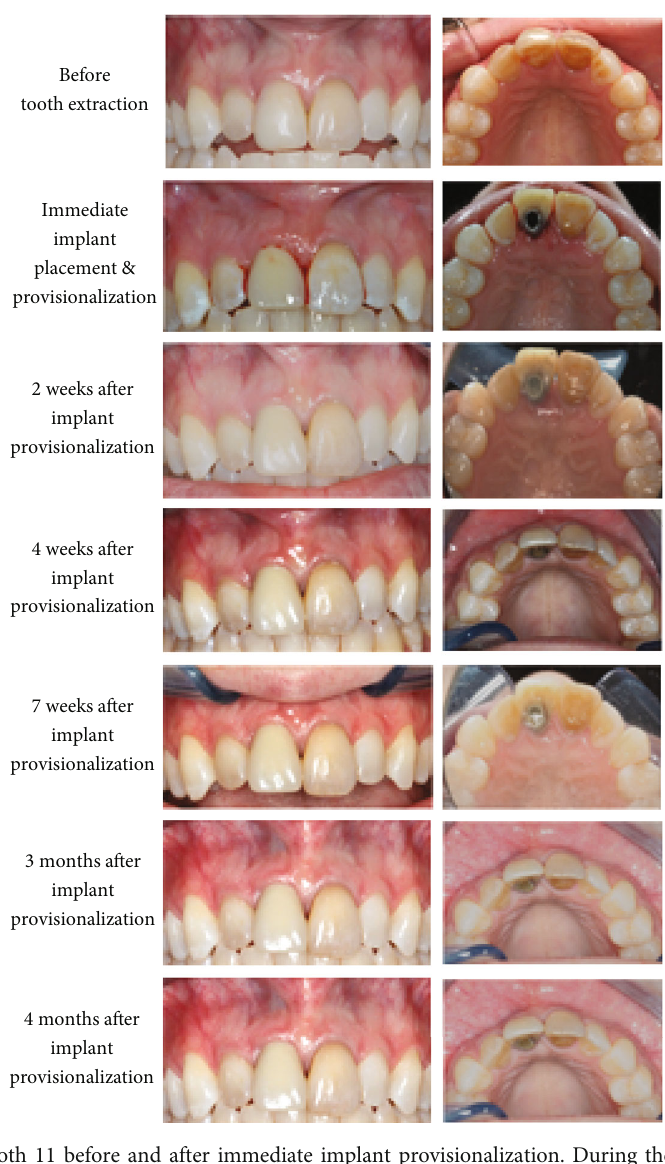
Figure 6: Clinical photos of tooth 11 before and after immediate implant provisionalization. During the 4-month follow-up period, the gingival tissue around implant was pink and healthy. The patient was satis fi ed with the esthetic outcome of the immediate implant provisionalization.